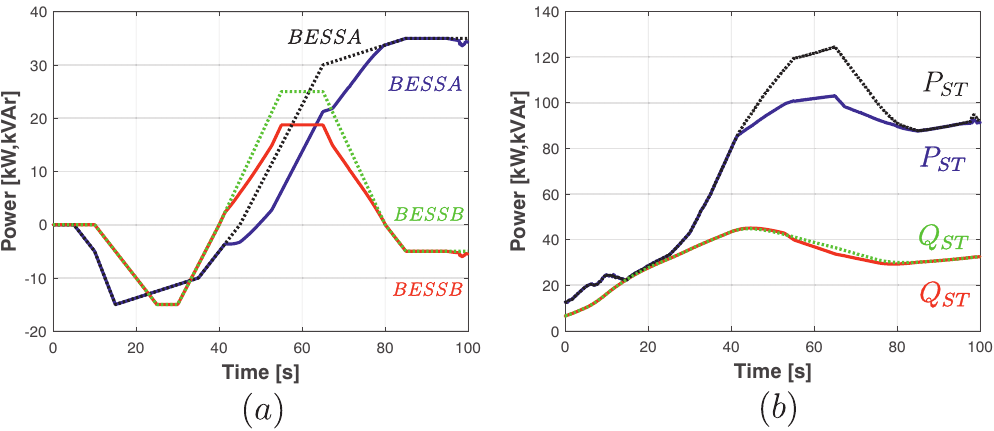
Figure 7. ( a ) Active power without controller BESS A (dotted green line), with overload controller (red line), active power without controller BESS B (dotted black line), with overload controller (blue line); ( b ) ST: Active power without controller (dotted black line), with overload controller (blue line), reactive power without controller (dotted green line), with overload controller (red line).